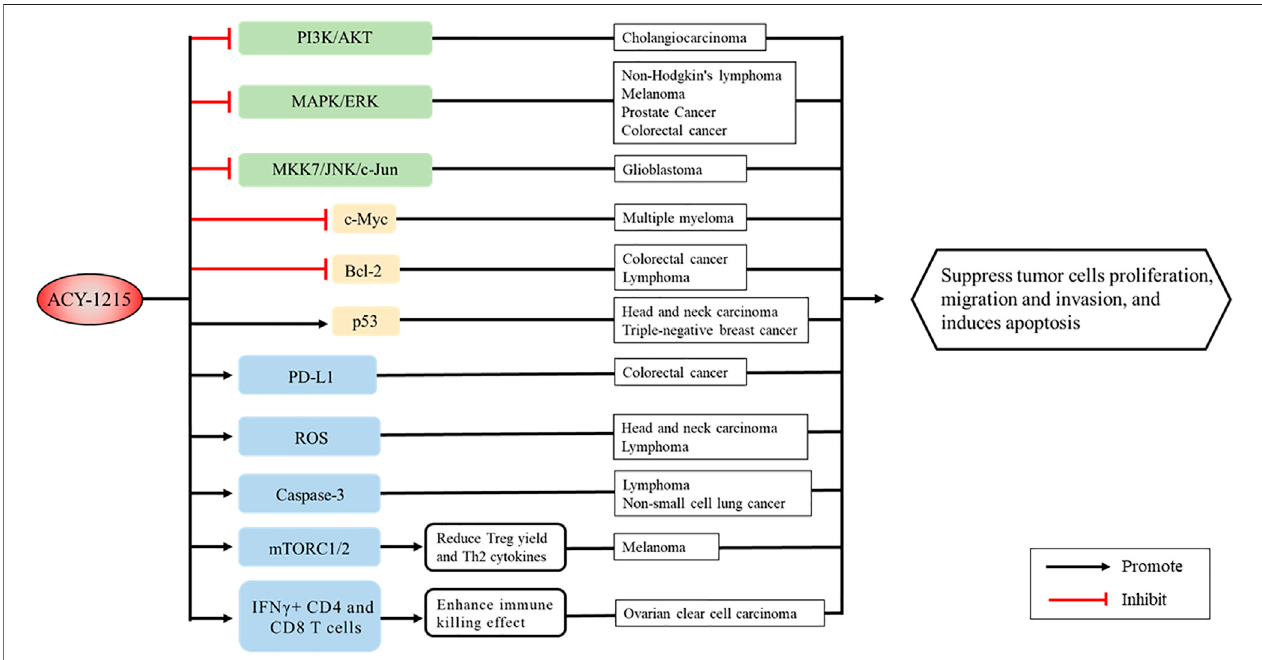
FIGURE 5 | Signaling pathways and proteins in cancer regulated by